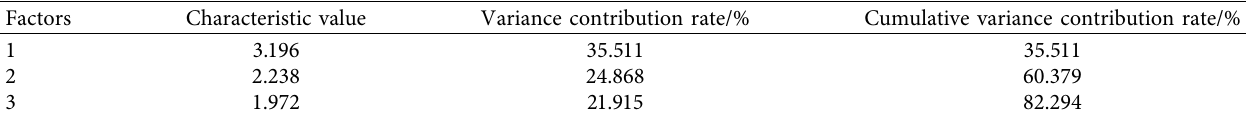
Table 1: Characteristic value and variance contribution of factor analysis of water quality indicators.